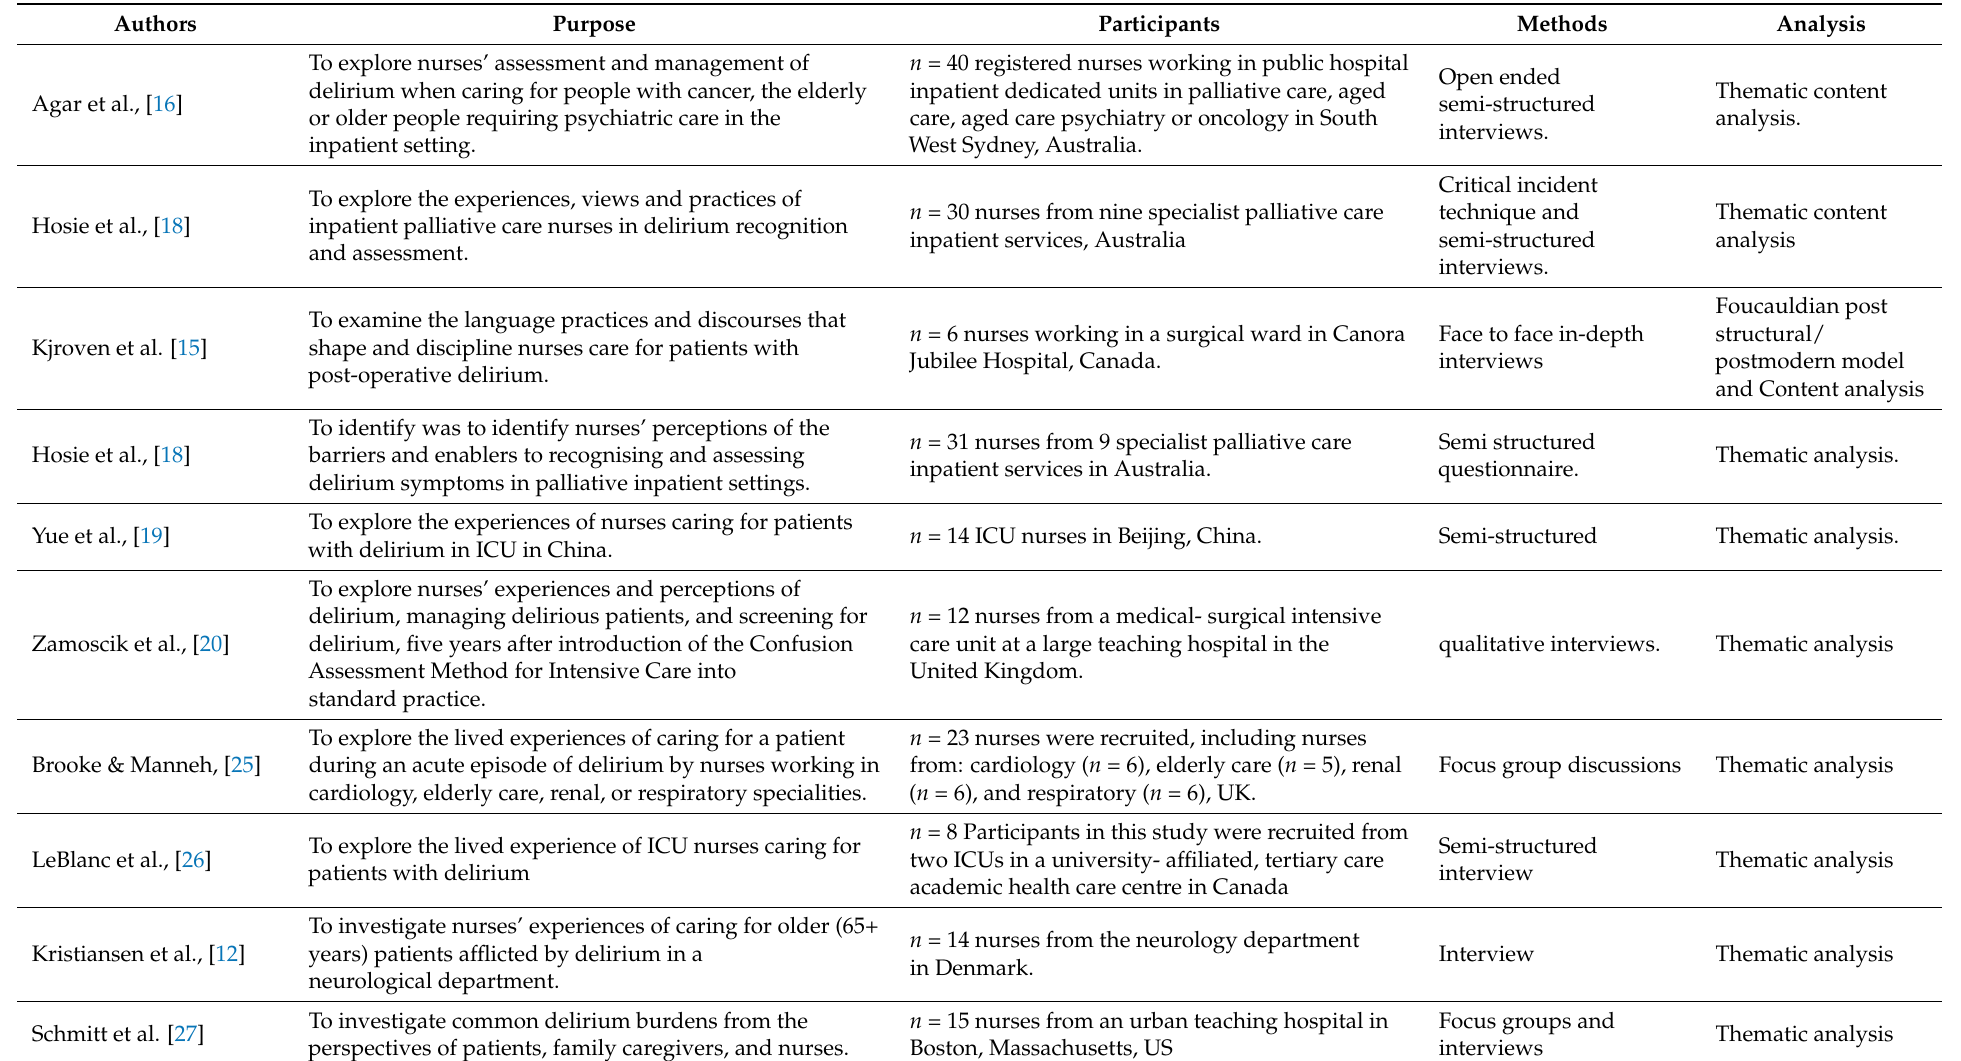
Table 1. Characteristics of the